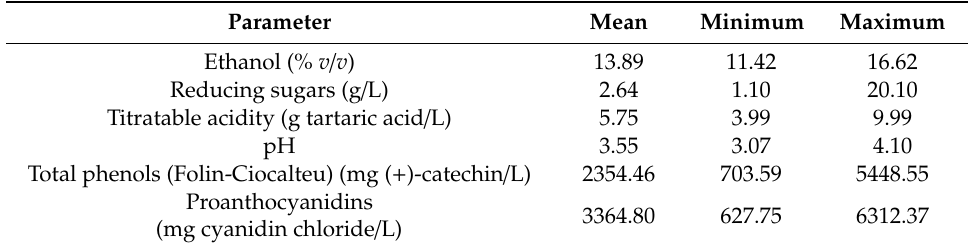
Table 4. Oenological parameters determined in the 74 single cultivar Italian red